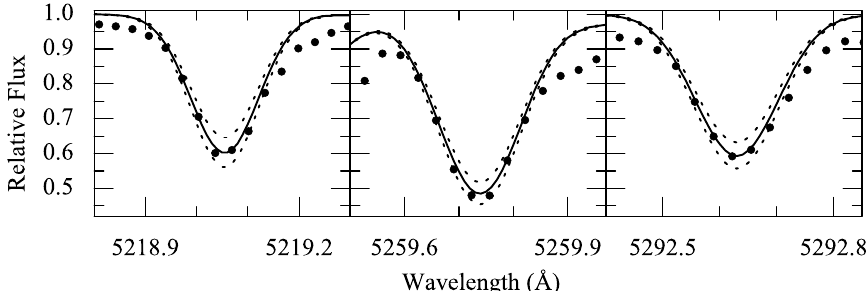
Fig. 19. Pr II lines in the spectrum of HD 209621. The synthetic spectra are given for the praseodymium abundance log ϵ (Pr) = 0 . 52 ± 0 . 15. 4050.33 ˚A line can be ∼ 0.2 dex or